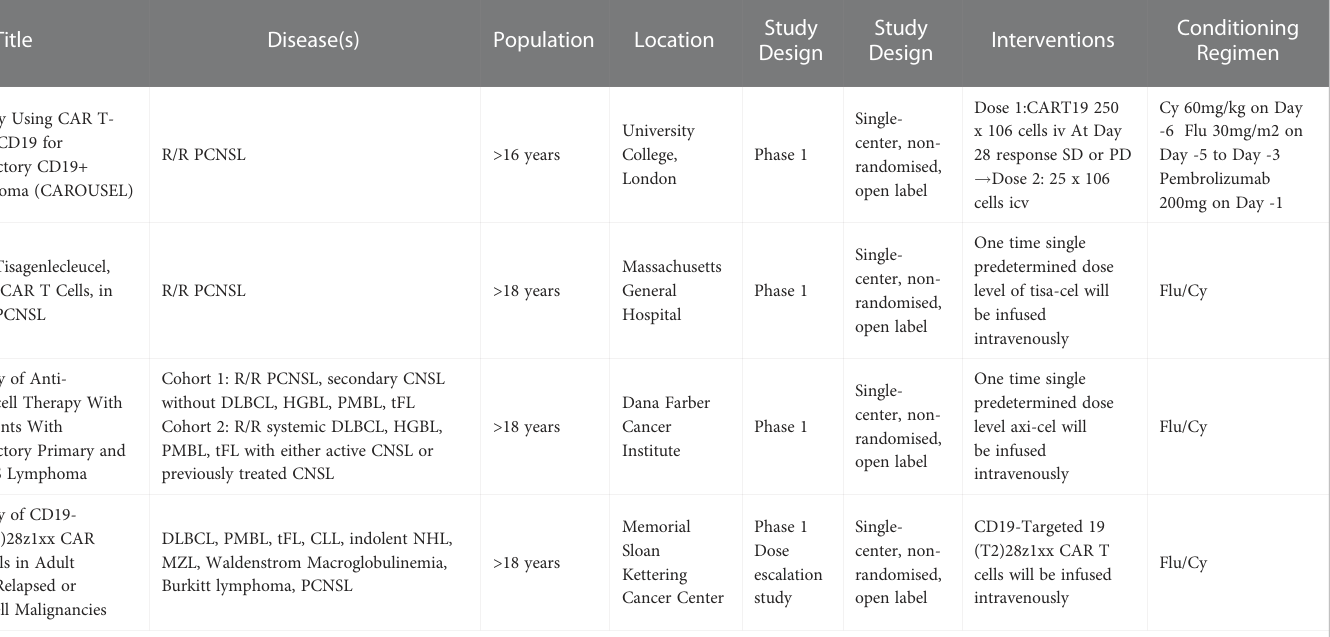
TABLE 2 Clinical trials of CAR-T cell therapy in